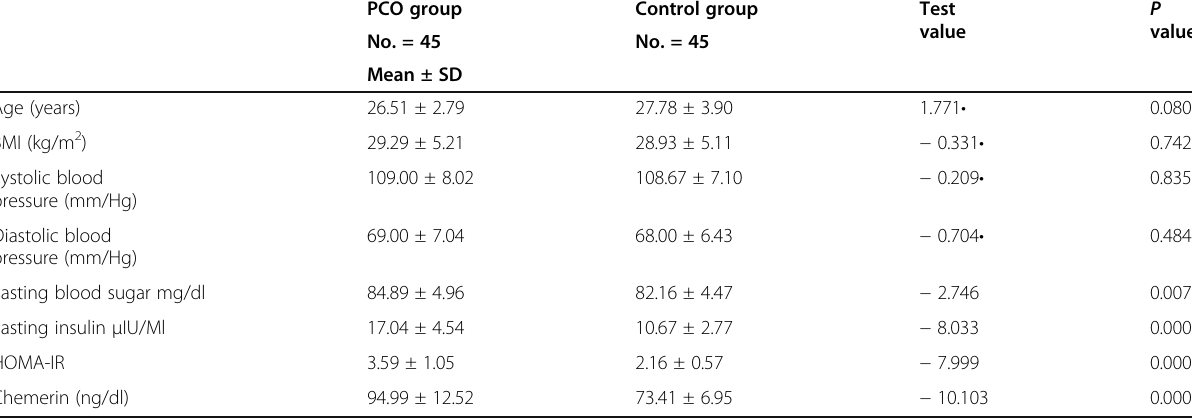
Table 2 Comparison between PCOS and control groups as regards all studied parameters PCO